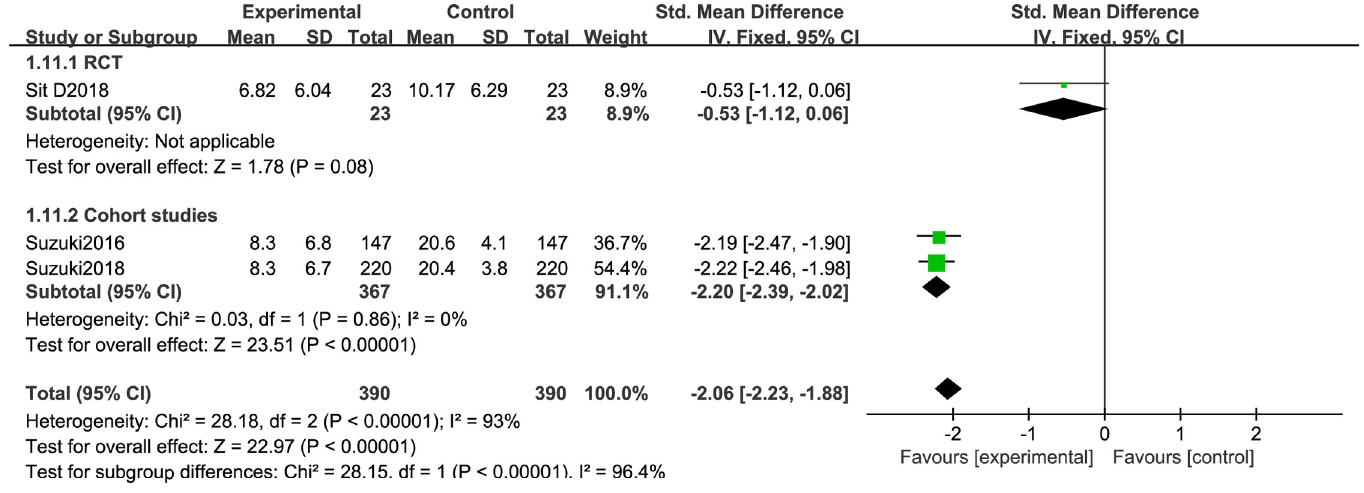
Fig 9. Forest plots with a color temperature greater than